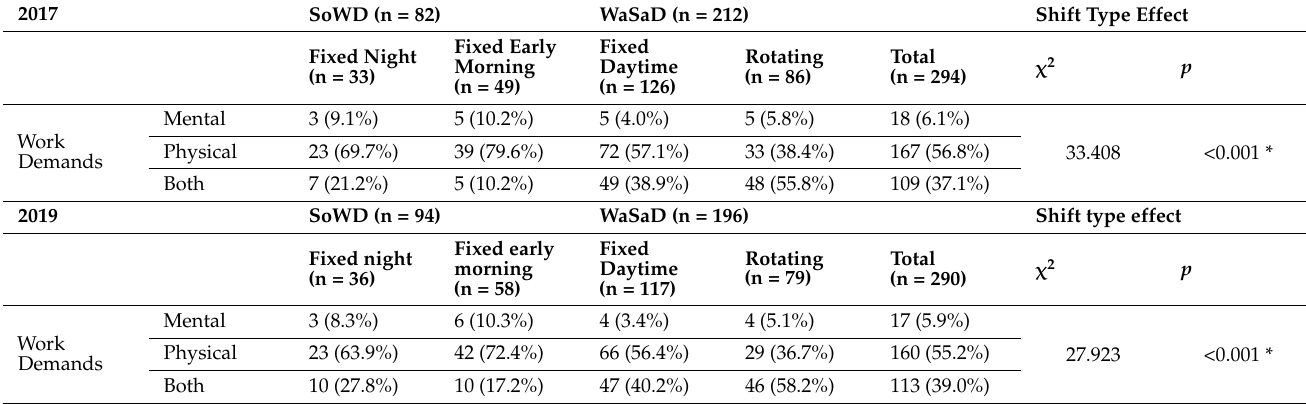
Table 2. Perception of work demands (Frequency (%)) in 2017 and 2019 by shift type and results of Chi-square test for homogeneity comparing shift